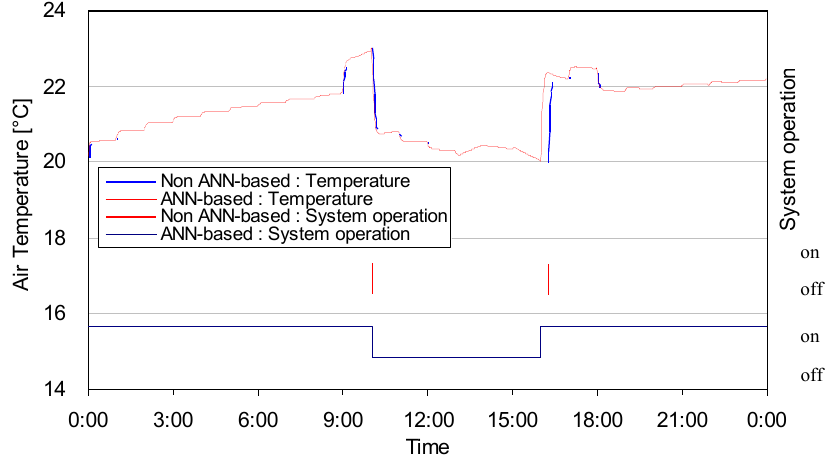
Figure 11. Indoor temperature and operation of heating system (Double skin envelope, 1 January